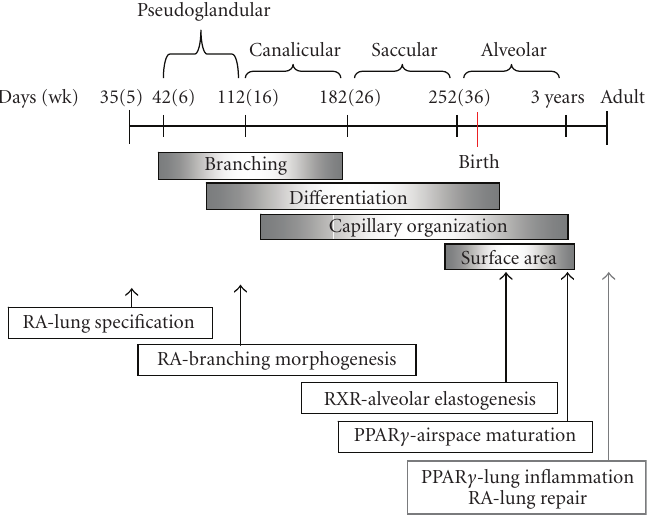
Figure 1: Retinoic acid and PPAR γ signaling are essential at many points during lung development. Lung development occurs in multiple stages (top), each involving critical processes (middle) and multiple regulatory factors. This schematic highlights the timeline for human lung development, though murine lung development occurs in similar stages. It is widely appreciated that retinoic acid signaling has e ff ects on all stages of lung development (bottom). Recently, PPAR γ has also been found to be a critical modulator of postnatal lung development. (Adapted from Mariani, T.J. Developmental genetics of the pulmonary system. In: Moody, S.A., Editor, Principles of developmental genetics. Burlington, VT: Academic Press, 2007:932-945. With the permission of Elsevier